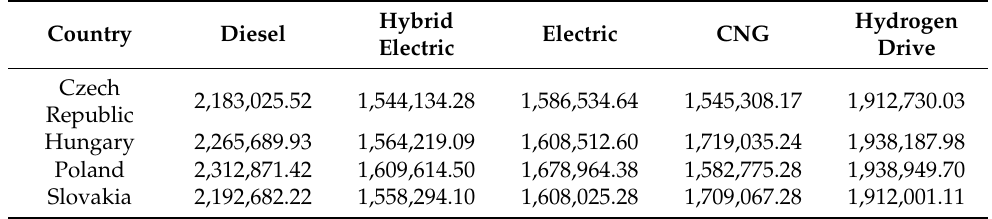
Table 8. The total cost of ownership of maxi buses (12 m) with different drive types in the V4 countries ( € ). Country